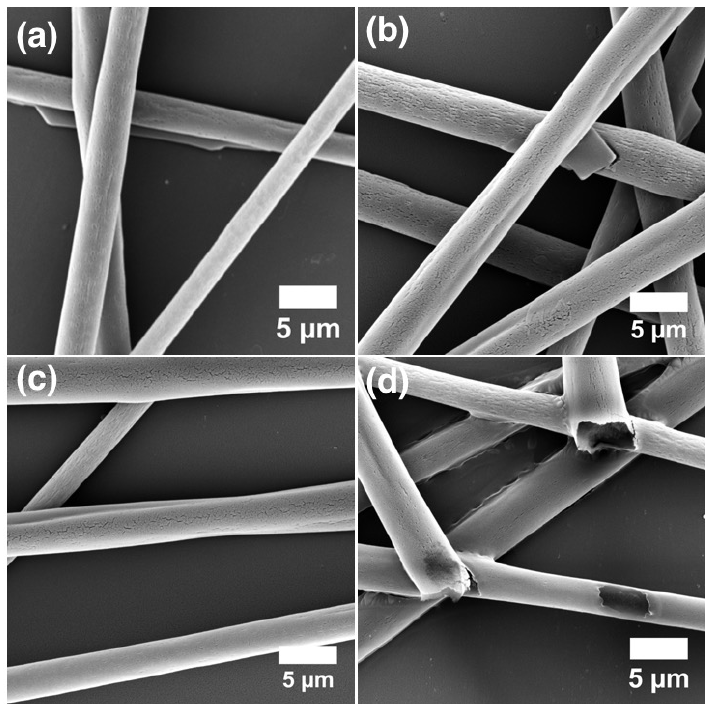
Figure 6. SEM image of LCE-PVP fibers: ( a ) without UV and heat exposure; ( b ) heated to 55 ◦ C; ( c ) after UV exposure at 55 ◦ ; and ( d ) after UV exposure at 55 ◦ C and subsequent heating to 75 ◦ C, above the clearing point of the